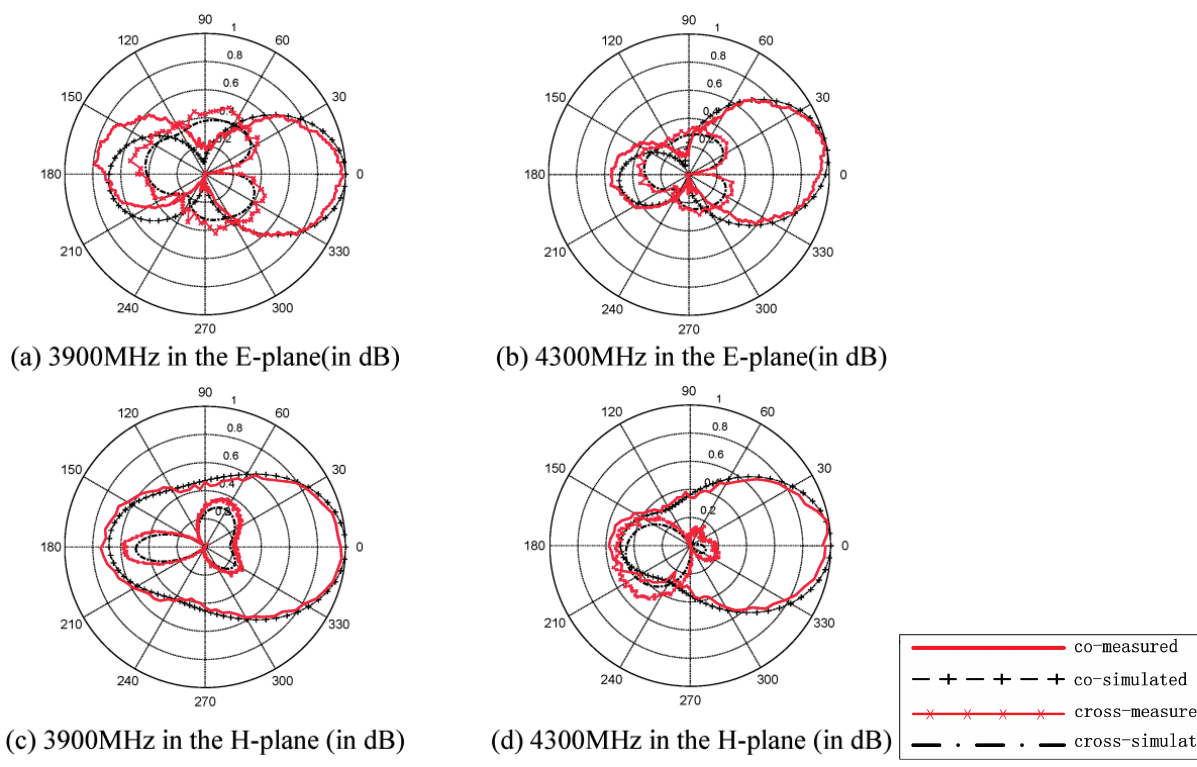
Figure 5. Measured and simulated co- and cross-polarizations of the proposed antenna in the E-plane of ( a ) 3800 MHz and ( b ) 4300 MHz and the H-plane of t ( c ) 3900 MHz and ( d ) 4300